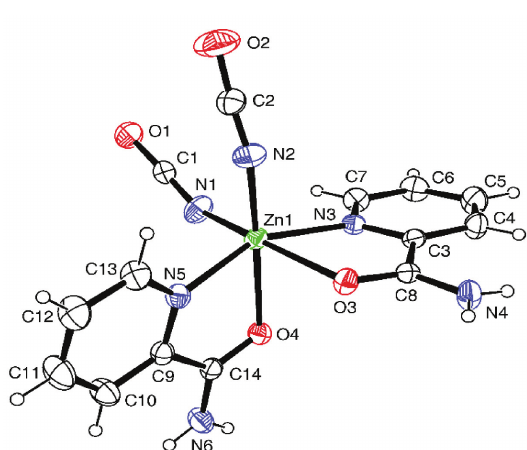
Figure 1a. Molecular structure of 1 with the atom numbering sche-